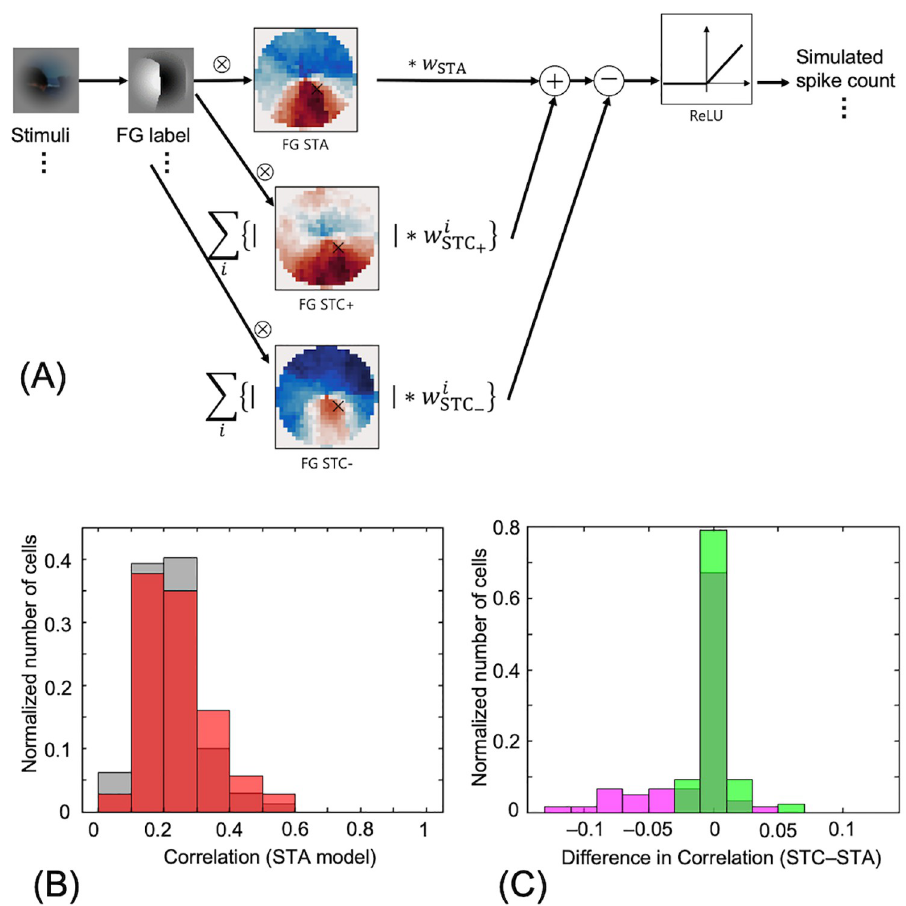
Fig 9. The model combining RF-FG STA and RF-FG STC s. (A) Illustration of the model combining RF-FG STA and RF-FG STC s. (B) Distribution of the correlation between the neural spike rate and the responses of the model with RF-FG STA but without RF-FG STC (STA model) in response to the corresponding filled stimuli. The gray and red bars indicate all examined neurons and the neurons with the good convergence and significant magnitude, respectively. (C) Distribution of the difference in the neural correlation between the STA model and STA+STC model. Red and green bars indicate those estimated for the filled and natural stimuli, respectively. The distribution of the difference between the STA and STA+STC models was centered around zero, indicating weak or no contribution of the RF-FG STC s.